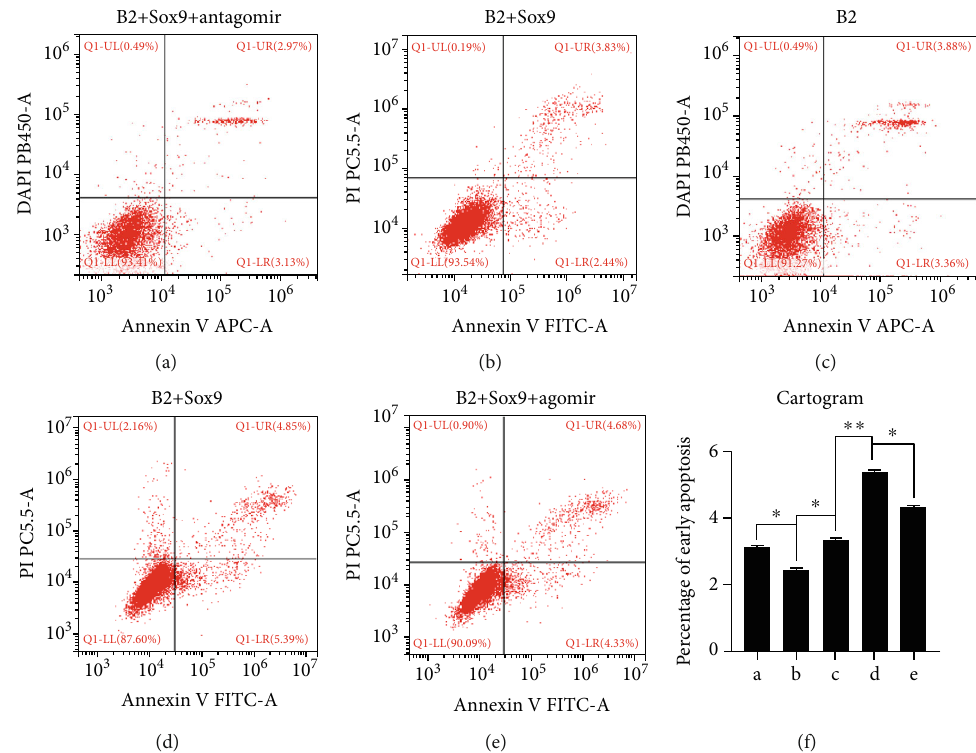
Figure 4: Flow cytometry was performed for detection of early apoptosis. (a – e) The percentage of early apoptosis in each group was shown. (f) ∗ p < 0 : 05 and ∗∗ p < 0 : 01 . B2: (Figure 3(b)) [27]. To verify the targeting relationship between